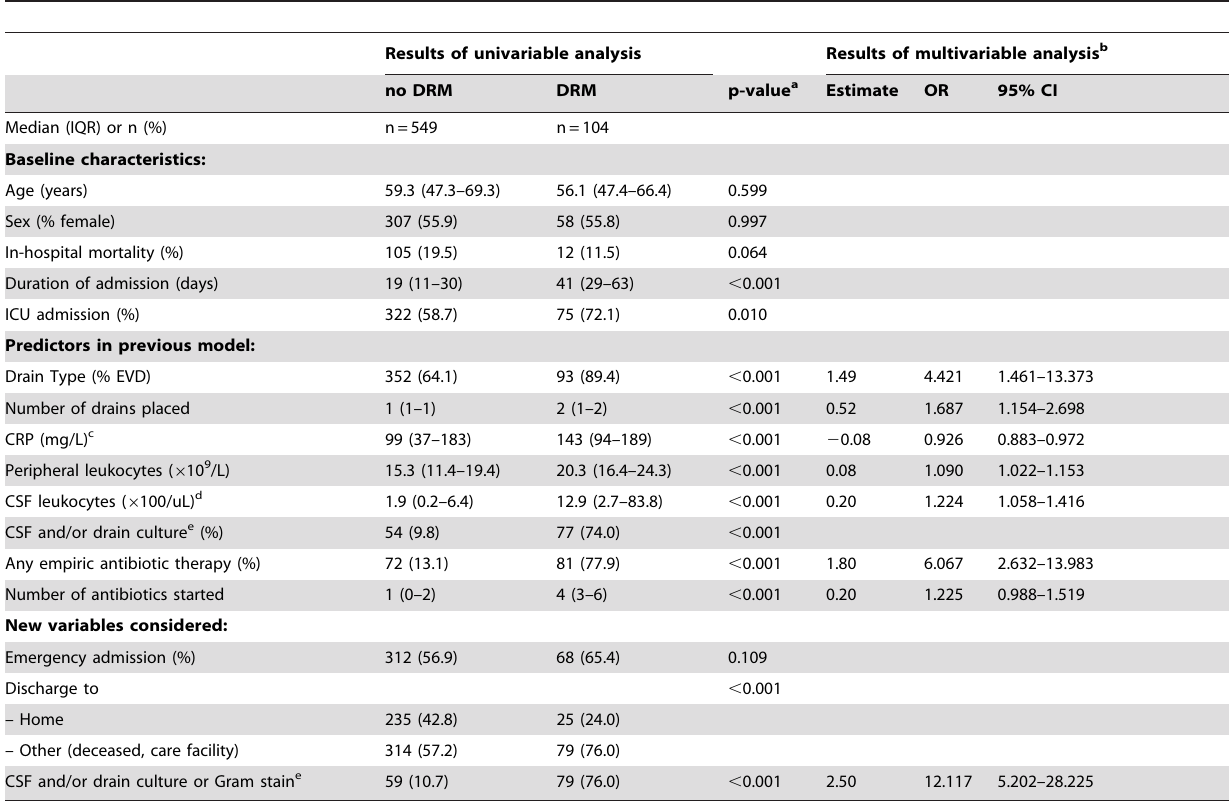
Table 2. Model update results for 2004–2011 data, including baseline characteristics and results of univariable and multivariable analysis.